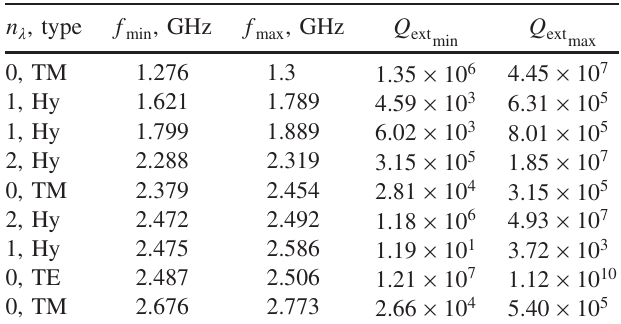
TABLE I. Lowest passbands of the MESA cavity.